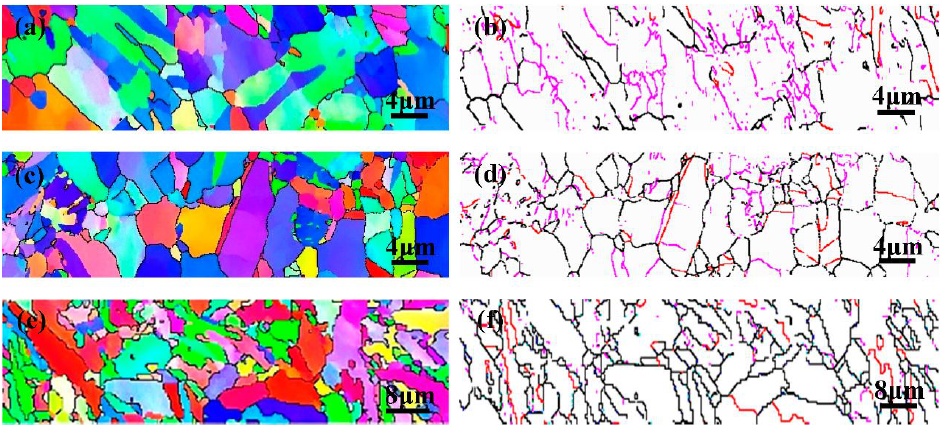
Figure 8. EBSD orientation maps and grain-boundary maps of joint: ( a , b ) SZ-top; ( c , d ) SZ-bottom and ( e , f ) BM.